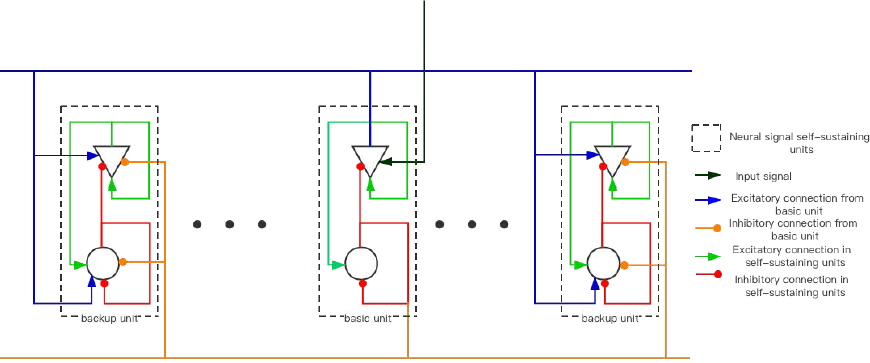
Figure 3. The SET network uses an HPNF model as a neural signal self-sustaining unit (NSSU). Triangles represent excitatory neurons (pyramidal cells, etc.) and circles represent inhibitory neurons (interneurons, etc.). The NSSU is divided into two types: basic unit and backup unit. The topology of the basic unit (backup unit) is identical to that of Figure 1c (HPNF). The difference between the basic unit and the backup unit is that the content stored in the backup unit is the backup in the basic